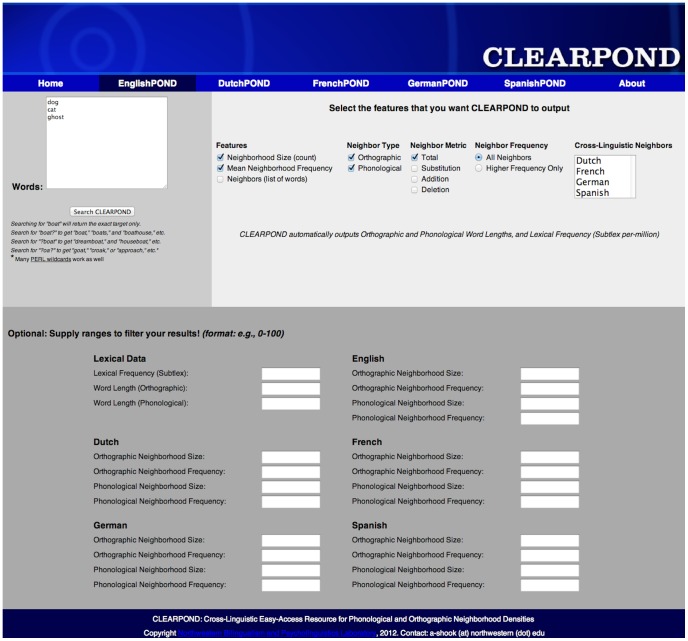
Screen-shot of the EnglishPOND portion of the CLEARPOND website, accessible at
http://clearpond.northwestern.edu
. CLEARPOND provides a user-friendly, web-based interface for obtaining Dutch, English, French, German, and Spanish phonological and orthographic neighborhood densities (or, PONDs). The search function allows users to search for POND information in any of the five languages using single word queries or by providing full lists of words. CLEARPOND provides a number of important psycholinguistic measures, such as neighborhood density and neighborhood frequency, both for within-language neighbors and foreign-language neighbors. With user-controlled output selection, researchers can choose the output parameters that are most relevant. In addition to allowing users to acquire data for specific words, CLEARPOND can also search by features so that researchers can generate new lists of words that meet precise criteria, such as a specific range of neighborhood sizes or lexical frequency (as provided by the Subtlex databases). Furthermore, multiple filters can be applied simultaneously, providing greater control for stimuli creation. Users also have the option of exporting their results directly to a text file, making it easy to create downloadable documents containing pertinent psycholinguistic measures for all of their stimuli. In addition to the web-based interface, more comprehensive lists containing all of the information provided by the database are available for download, so that the entire CLEARPOND database can be accessed offline.